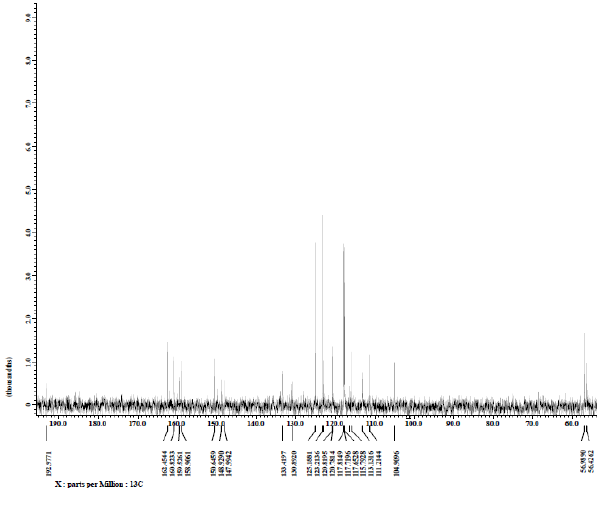
Figure 4. Spectra of C-NMR Table IV. Results of statistical analysis of % analgesic protection using one-way ANOVA (I) Groups (J)